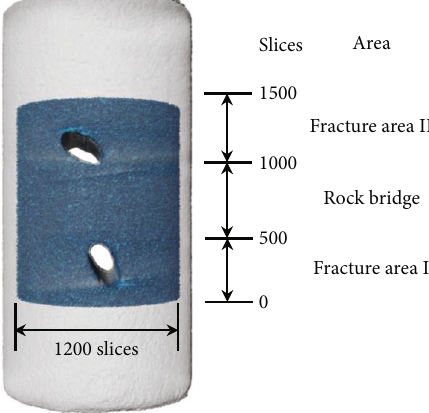
Figure 5: Extraction of regions of interest in rock sample and three